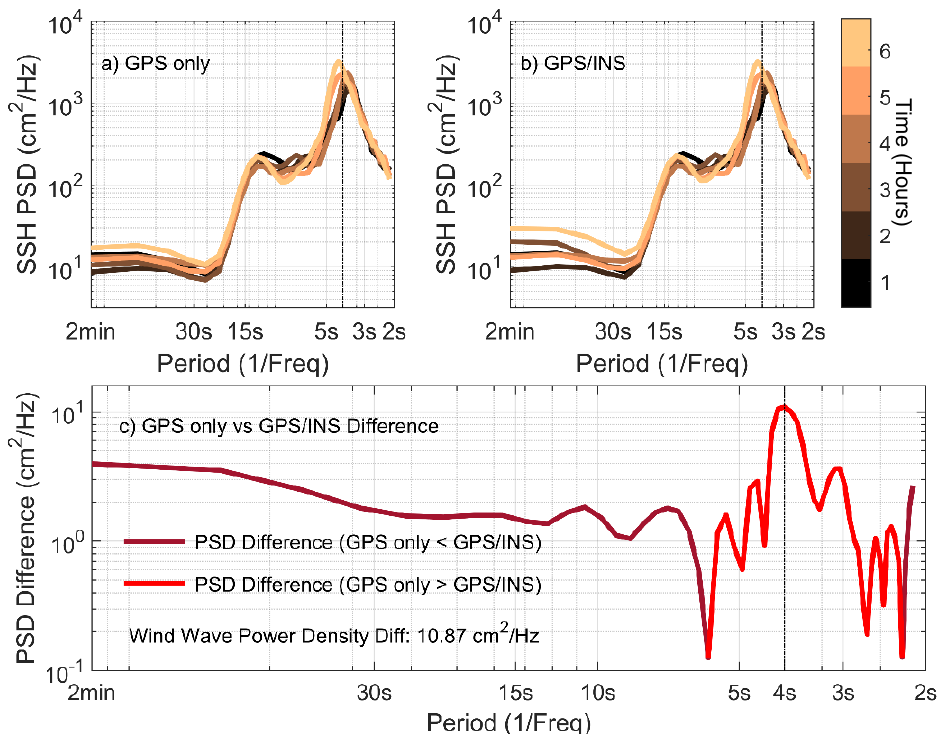
Figure 8. High frequency Power Spectrum Density (PSD) of GPS only ( a ) and GPS/INS SSH ( b ) solutions; Panel ( c ) shows differences of PSD between GPS only and GPS/INS, taken as the absolute value of GPS only minus GPS/INS, but marked in different colours to show which solution has the dominant noise; Vertical thin black line indicates maximum PSD difference; Colormap indicates six consecutive 1-h windows for the upper panel of ( a ) and ( b ).